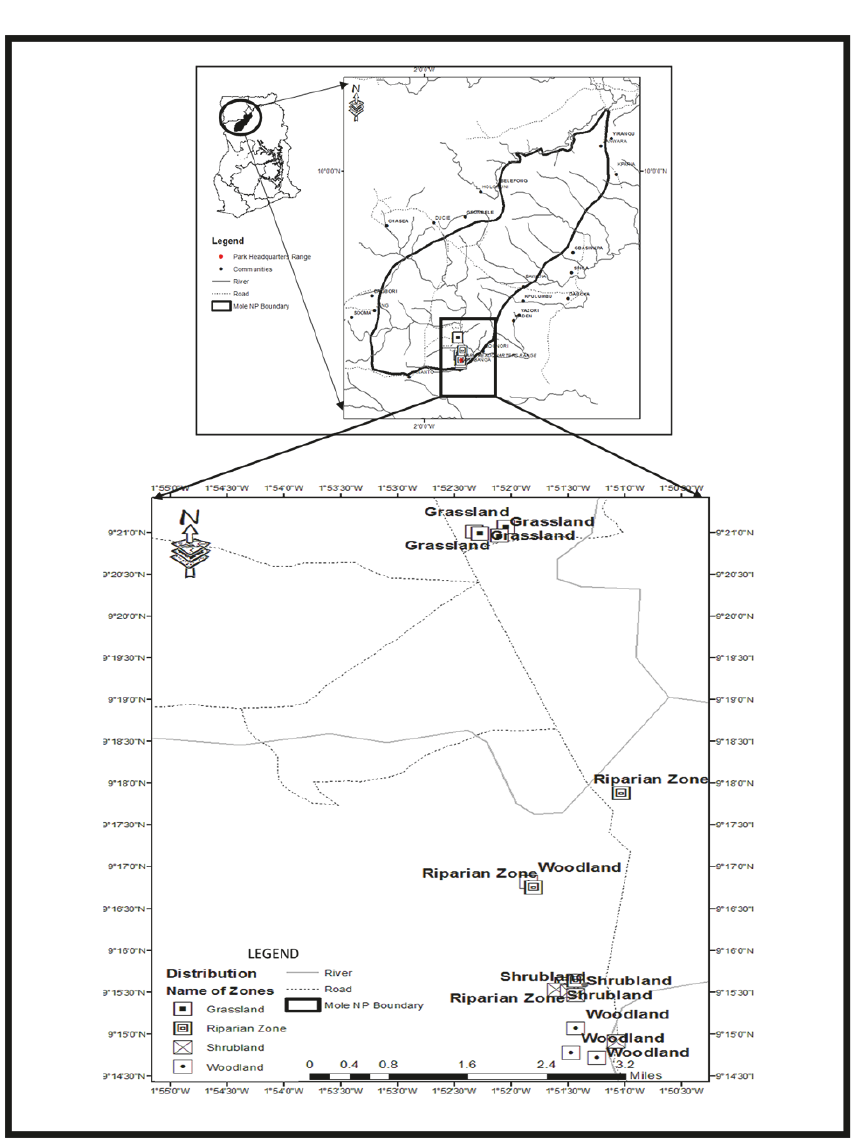
Figure 1: Map of Ghana, showing the study area at Mole National Park, in Northern